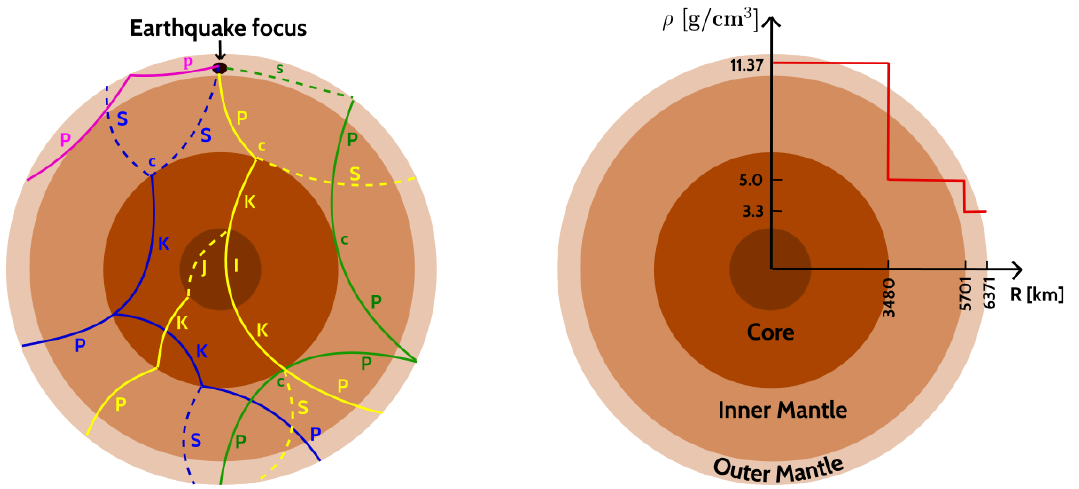
Figure 1 . The left panel shows examples of seismic waves originating at the focus of an earthquake (black dot) and traveling inside Earth. The dashed and solid curves represent the S (shear) and P (pressure) waves, respectively. Colored curves represent the trajectories of these seismic waves. The components (S, P, K, I, J, s, p, c) of the seismic waves are described in the text. The right panel shows a three-layered model of Earth consisting of the core, inner mantle, and outer mantle. The red curve depicts the density profile of Earth as a function of radial distance from its